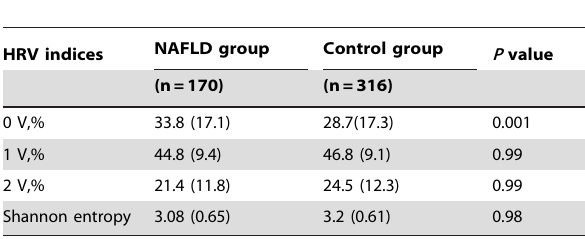
Table 4. Comparison of non-linear HRV indices between NAFLD subjects and